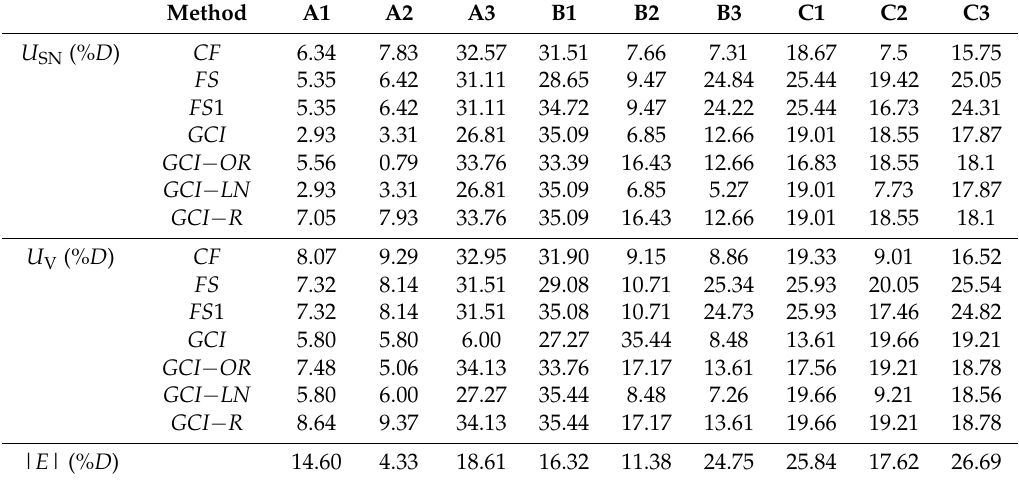
Table 6. Validation results for concentration at monitoring points on grids